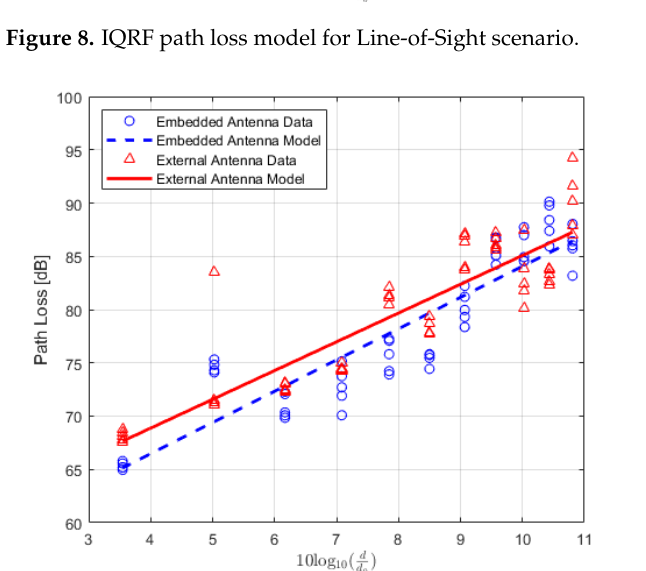
Figure 9. IQRF path loss model for Non-Line-of-Sight scenario